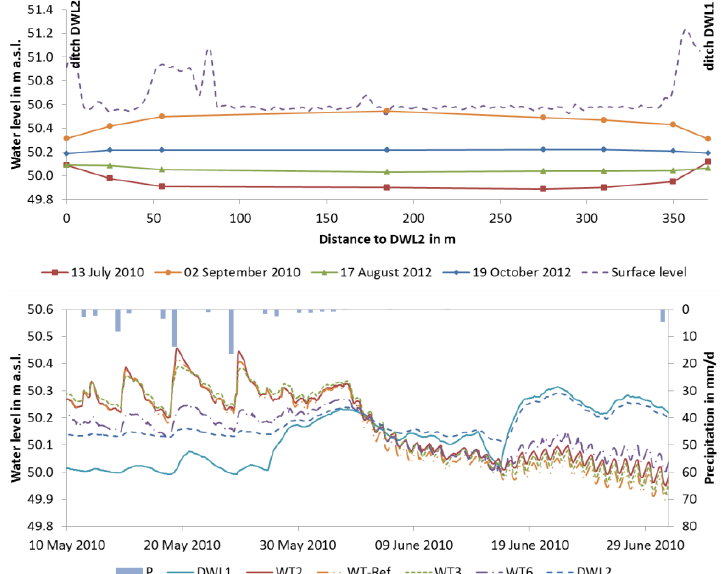
Figure 4. Water levels of the transect of ditch and groundwater gauges for different drainage/sub-irrigation situations for selected dates ( top ) and as a time series ( bottom ).